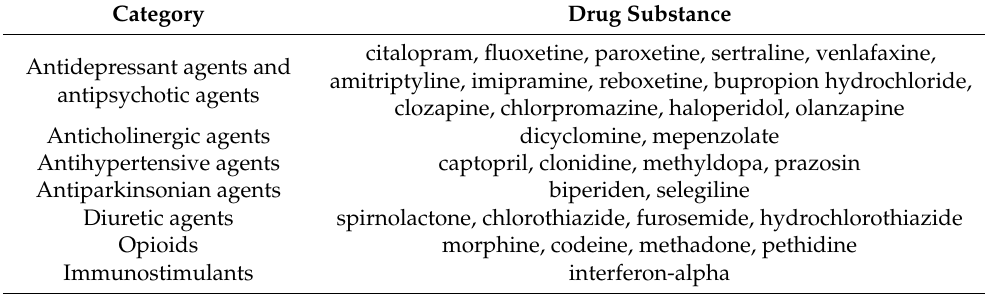
Table 1. Category of xerogenic medications and active pharmaceutical ingredients